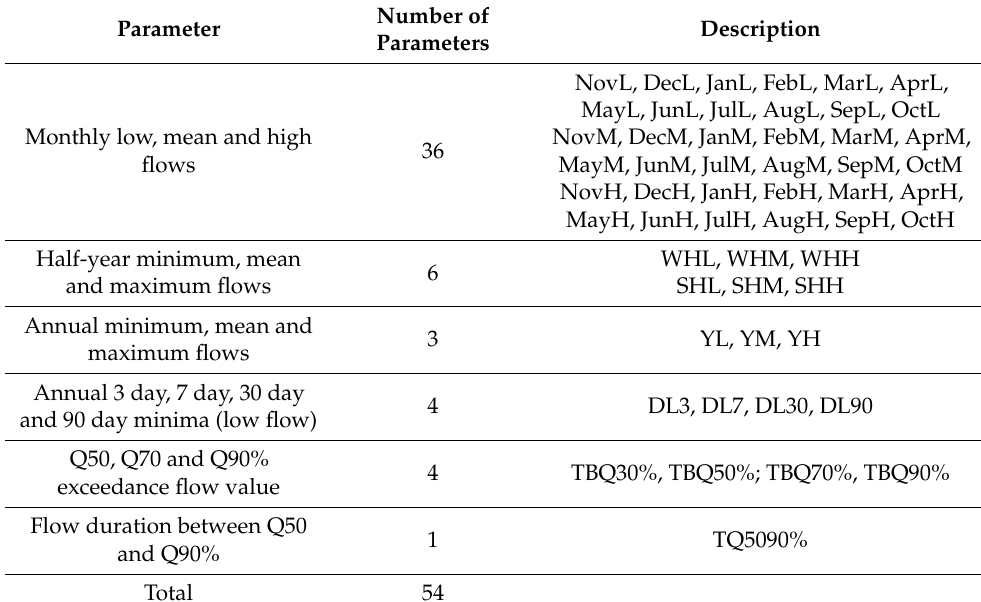
The table is a compilation of the analysis period and flow characteristics (periods: Y—year; WH—winter half-year; SH—summer half-year; months—Jan., Feb., Mar., Apr., May, Jun., Jul., Aug., Sep., Oct., Nov., Dec.; D—day) (flow characteristics: L—low flow (minimum), M—mean flow, H—high flow